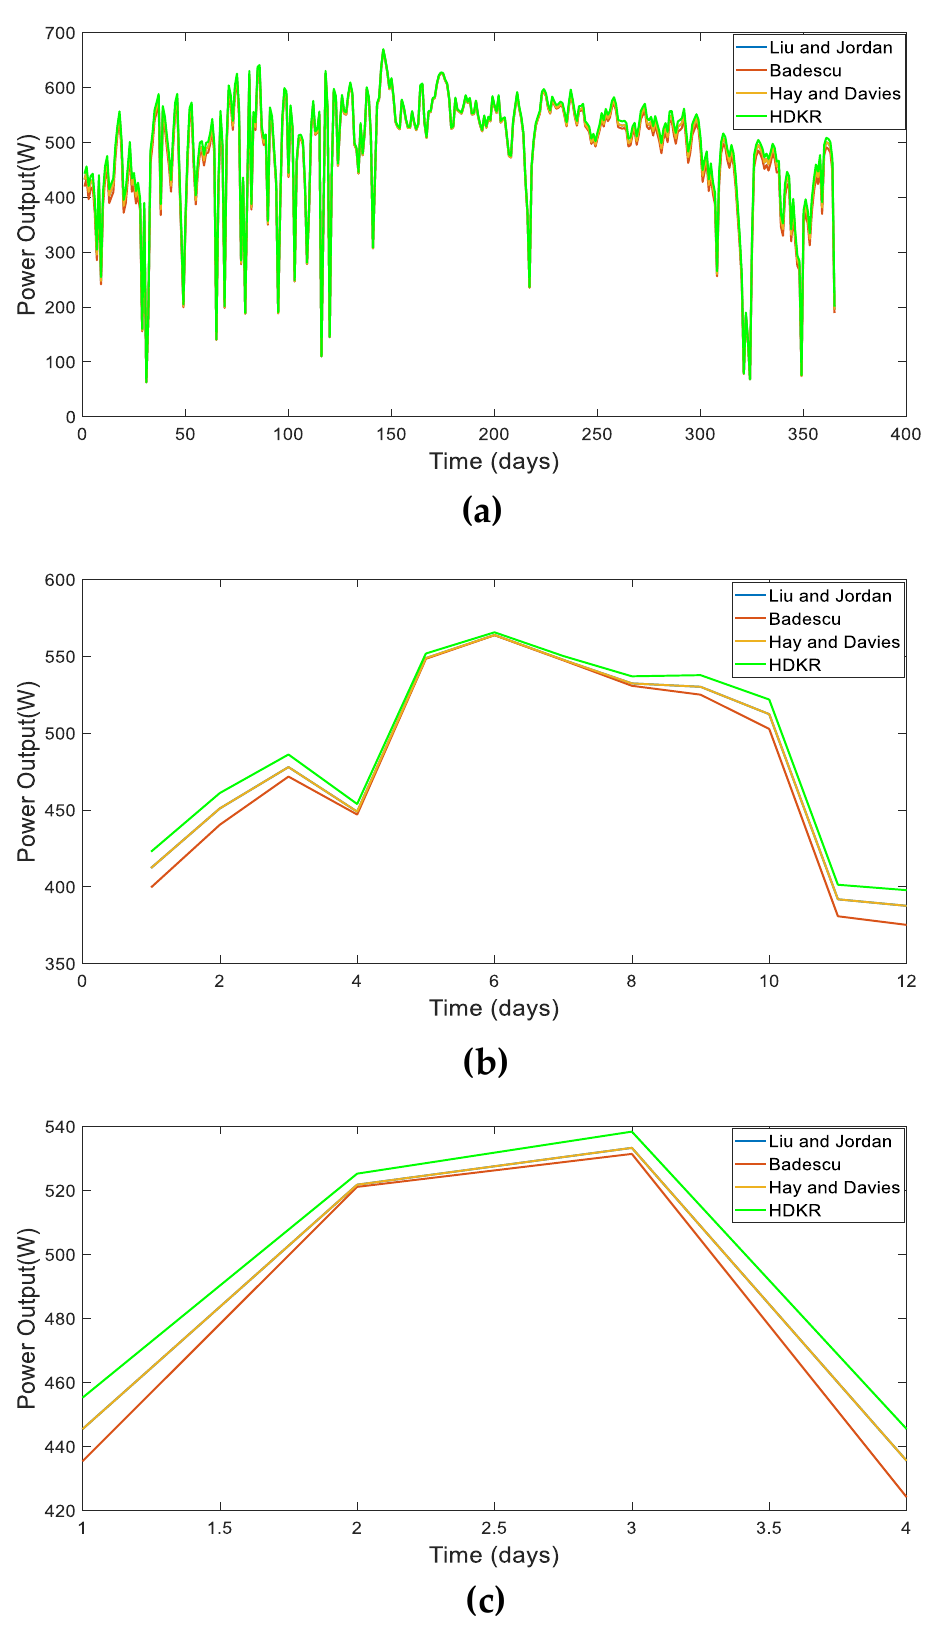
Figure 7. PV power output comparison between different models in Dhahran city for different periods: ( a ) NP = 365; ( b ) NP = 12; ( c ) NP = 4.